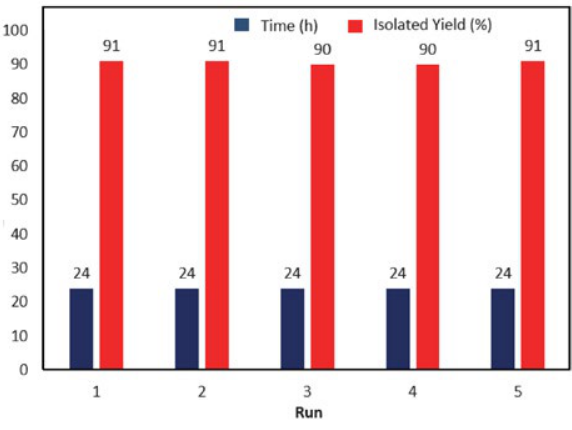
Figure 1. The one-pot condensation reaction between isatin ( 1a ) (1 mmol, 0.147 g), 5,5-dimethylcyclohexane-1,3-dione ( 2a ) (1 mmol, 0.140 g) and cyclohexyl isocyanide ( 3a ) (1 mmol, 0.109 g) in the presence of recovered SDS in water (5 mL) under reflux con-